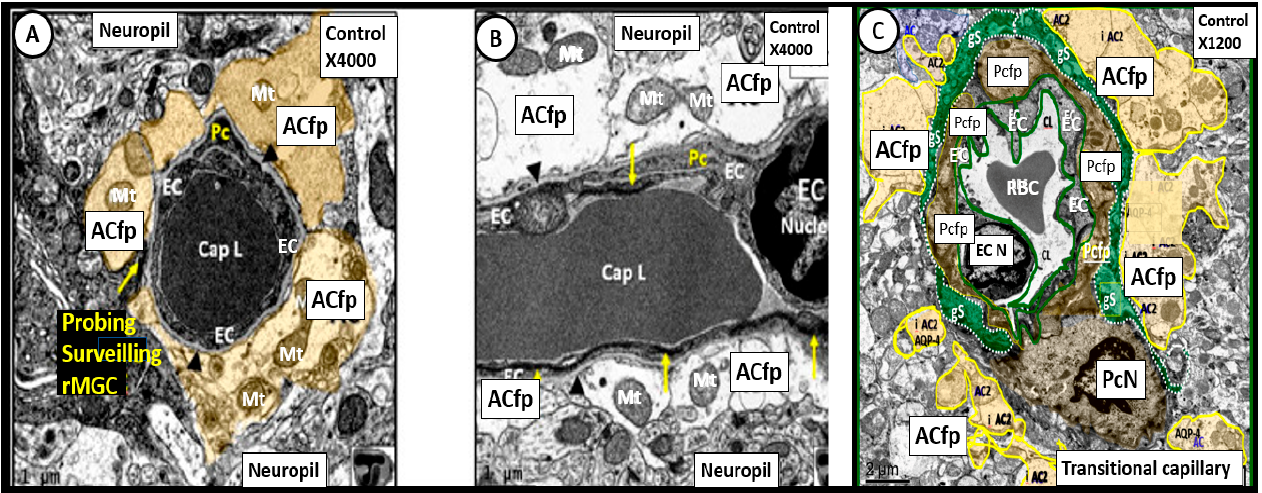
Figure 5. Neurovascular Unit Capillary (NVU) in control non-diabetic models. Panels ( A ) (cross section), ( B ) (longitudinal section) and ( C ) (cross section) depict the normal NVU composed of the endothelial cell (EC), pericyte foot processes (Pcfp), astrocyte foot processes (ACfp) and the ramified microglia cell (rMGC). Note in panel ( A ) that the rMGC is probing the NVU to surveil for any injury to the NVU. Note how tightly the Pcfp and the ACfp adhere and abut to the basement membrane of the ECs. Additionally, note the ACfp are pseudo colored yellow in panels ( A , C ) and reveal their electron lucent cytoplasm in panel ( B ), and the nanometer glymphatic space (gS) is pseudo colored green in panel ( C ). Varying magnifications upper right of each panel. Images are reproduced and modified by CC 4.0 [40].